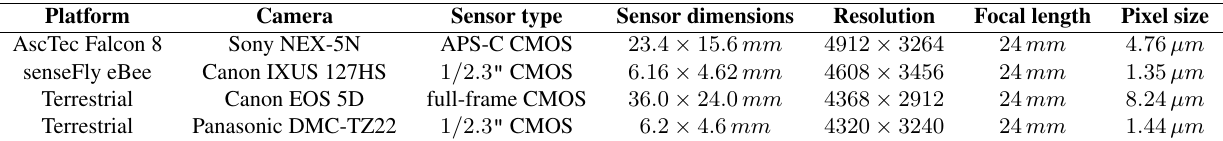
Table 1: Camera and sensor specifications.